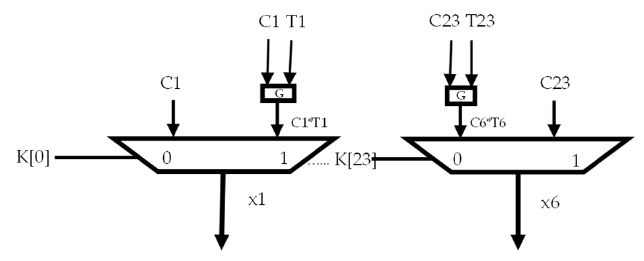
Figure 4. Implementation of time-varying obfuscation.